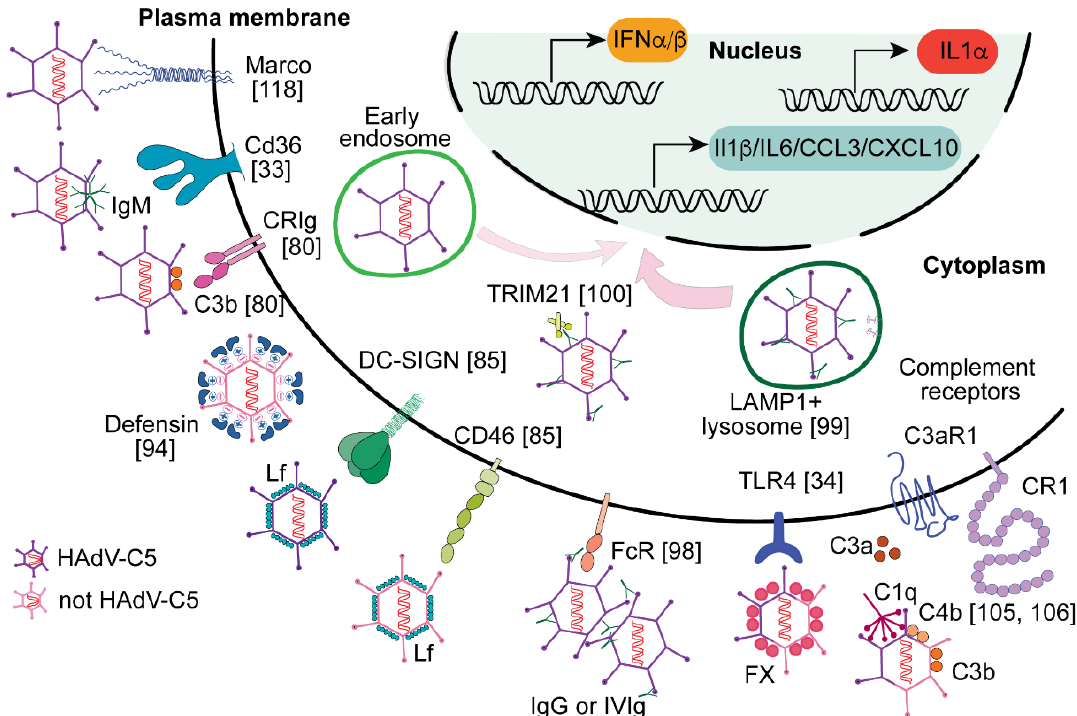
Figure 3. Factors enhancing cytokine and chemokine production in response to adenovirus infection. Different factors that bind to adenovirus particles can change the receptor selectivity and target the virus to macrophages and dendritic cells in the absence of the cognate virus receptors. The data for individual signaling molecules as reported in references from [33–118], are shown in parentheses adjacent to indicated proteins.